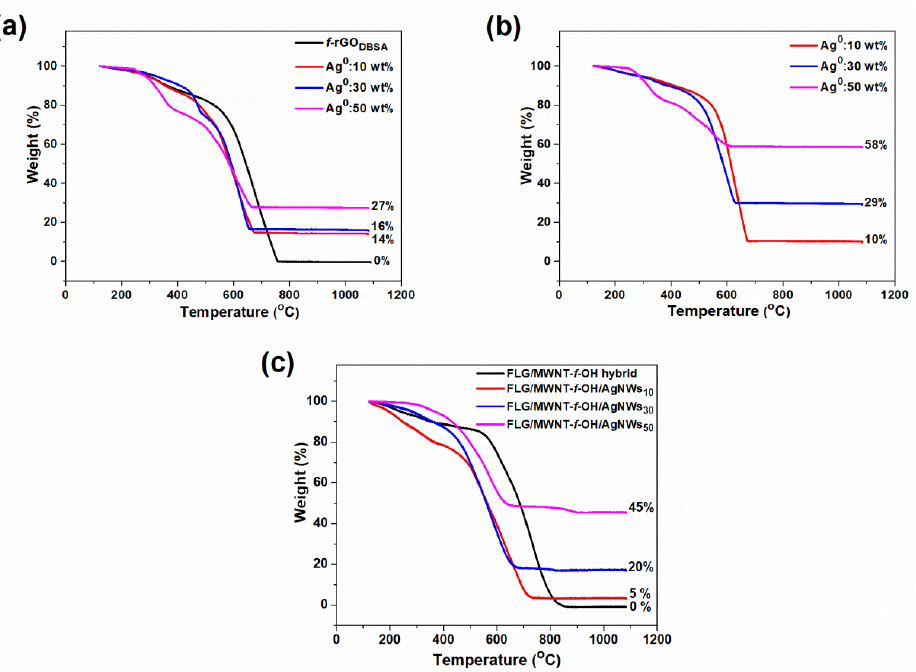
Figure 5. TGA curves for f -rGO DBSA /AgNWs hybrid systems with three different metal loadings (10, 30, and 50 wt %) prepared with the ( a ) physical mixture and ( b ) in situ method. The curve for the pristine f -rGO DBSA is also given for comparison (Figure 5a). ( c ) TGA curves for FLG/MWNT- f -OH and FLG/MWNT- f -OH/AgNWs.